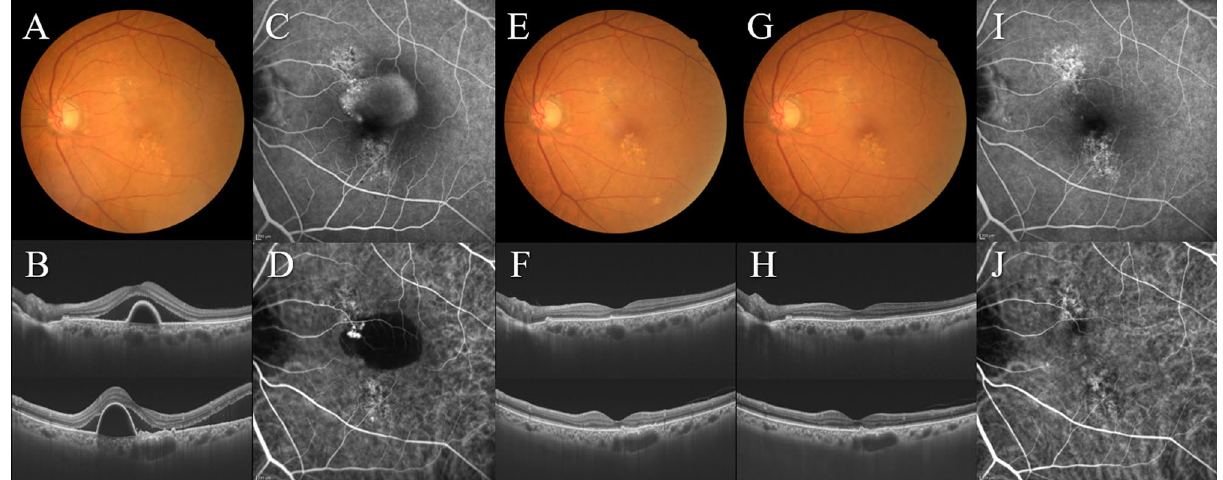
Figure 4. Images of the left eye of a 76-year-old man with polypoidal choroidal vasculopathy. Best-corrected visual acuity (BCVA) was 0.22 logarithm of the minimum angle of resolution (logMAR) units. ( A ) Color fundus photograph shows retinal pigment epithelium (RPE) degeneration and detachment accompanied by serous retinal detachment (SRD) at the macular area. ( B ) 12 mm horizontal and vertical B-mode optical coherence tomography (OCT) images through the fovea show dilated outer choroidal vessels associated with RPE detachment and SRD. The CMT and CCT are 388 μm and 360 μm, respectively. ( C ) Fluorescein angiography (FA) shows window defects, leakage, and pooling to the RPE detachment at the macular area. ( D ) Indocyanine green angiography (ICGA) shows polypoidal lesions in the RPE detachment. One month after the first injection of brolucizumab: BCVA of the left eye is 0.00 logMAR units. ( E ) Color fundus photograph shows neither RPE detachment nor SRD but RPE degeneration can be seen in the macular area. ( F ) 12 mm horizontal and vertical B-mode OCT images through the fovea show no SRD but there are dilated outer choroidal vessels associated with a shallow irregular RPE detachment. The CMT and CCT are 146 μm and 344 μm, respectively. One month after the third injection of brolucizumab: BCVA of the left eye is -0.08 logMAR units. ( G ) Color fundus photograph shows RPE degeneration at the macular area. ( H ) 12 mm horizontal and vertical B-mode OCT images through the fovea show dilated outer choroidal vessels associated with a shallow irregular RPE detachment. The CMT and CCT are 148 μm and 303 μm, respectively. ( I ) FA shows no leakage or pooling but there are window defects at the macular area. ( J ) ICGA shows no polypoidal